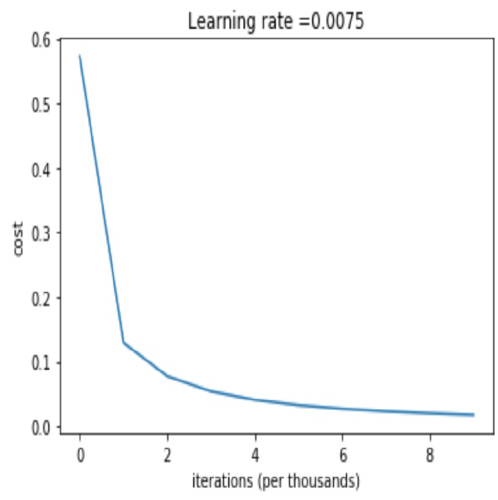
Figure 10. Accuracy of the DTBDNN model.